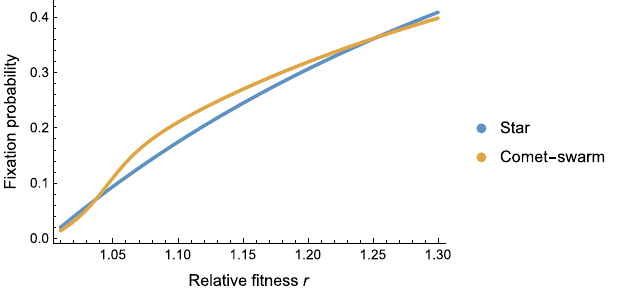
Figure 4. The Comet-swarm  NC